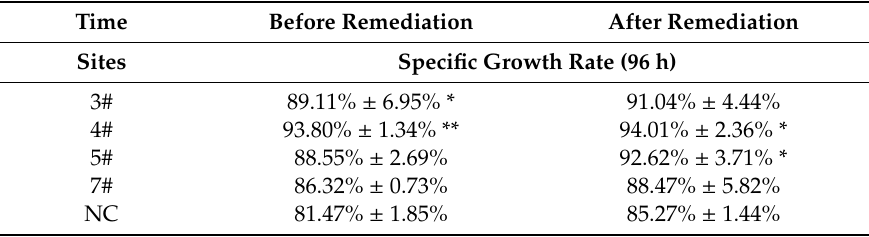
Table 3. Specific growth rate (96-h) of C. vulgaris to overlying water before and after remediation. Time Before Remediation After Remediation Sites Specific Growth Rate (96